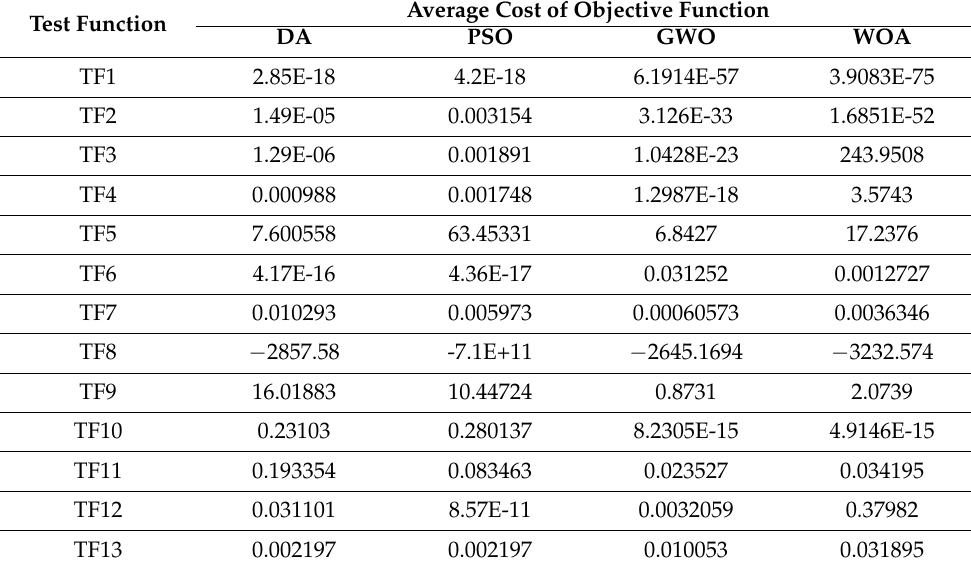
Table 7. Results provided by the algorithms for test